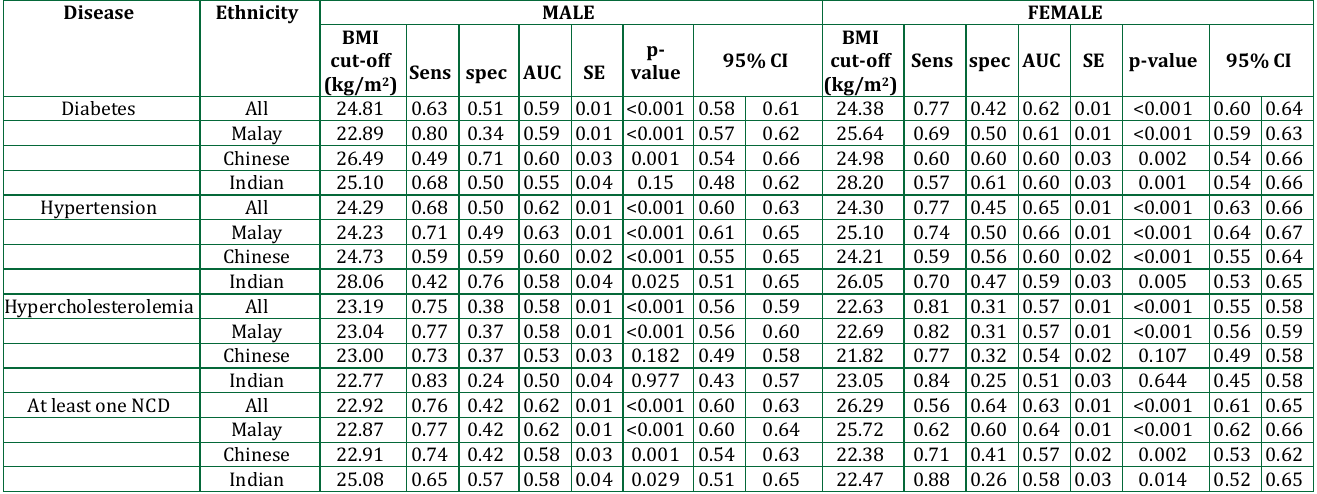
Table 3: Optimal BMI Cut-offs Associated with cardiovascular risk factor (CRF) by Gender and Ethnicity